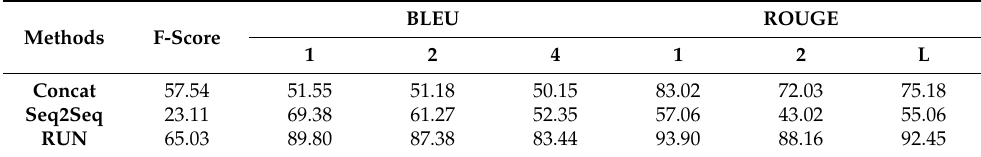
Table 3. The rewrite performance of three different methods.